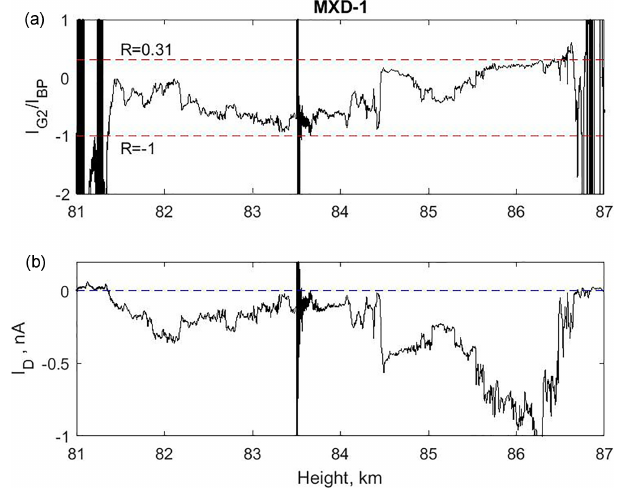
Figure 2. The ratio of the currents to G2 and BP in panel (a) compared to the current I D in panel (b) . The large disturbance at ∼ 83 . 5km in altitude is caused by a squib being fired to open for another experiment on the payload. The values of R , at and out- side the borders of the cloud, at 81.36 and 86.85km in height, are to be neglected since the dust density there is low or zero and R is therefore dominated by noise and uncertainties in their background